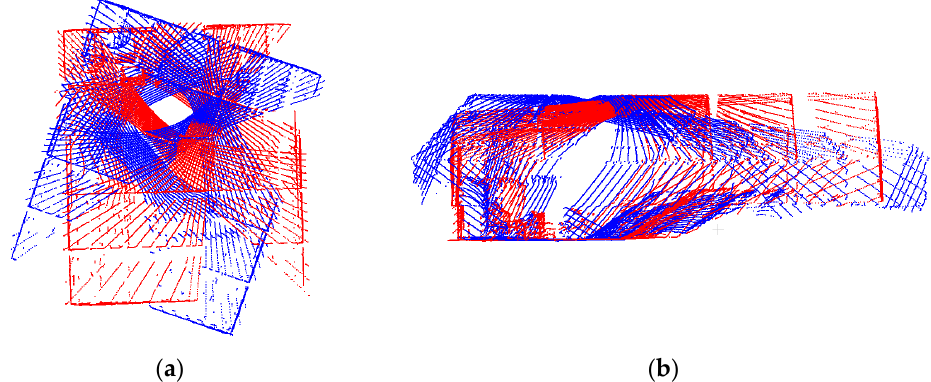
Figure 11. Coarse registration results using nominal rotation angles for two scans ( 𝑘 = 3 and 𝑘 = 5 ) in the US-231 dataset: ( a ) top-view and ( b ) side view. Point clouds are colored by scan ID.